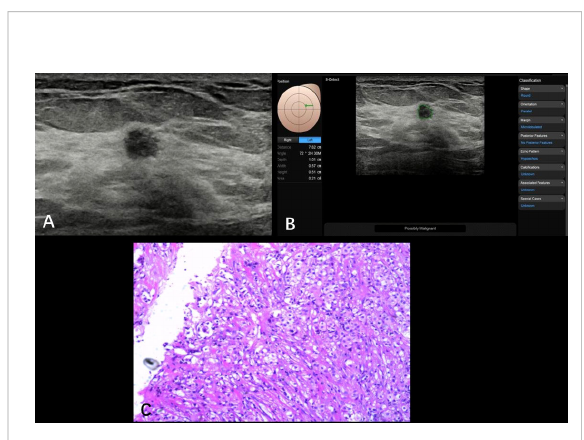
FIGURE 3 Fibroadenosis with fi broadenoma formation from a 35-year-old patient (BI-RADS 4a). A hypoechoic nodule (1.09 × 0.82 cm) was found at the 3 o ’ clock point of her left breast; ultrasound graphic showed glossy edge, irregular shape, partly angulated, and nonuniform internal echo (A) . S-Detect arti fi cial intelligence recommendation was “ possibly malignant ” and the BI-RADS score receded from 4a to 4b (B) . Pathologically con fi rmed as breast fi broadenosis with fi broadenoma formation (C) .